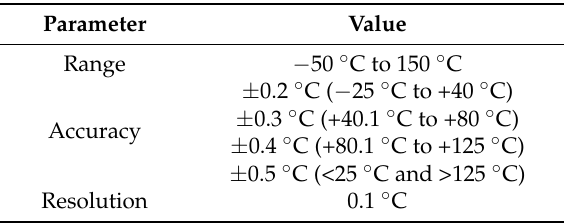
Table 3. Thermometer, Testo 720,